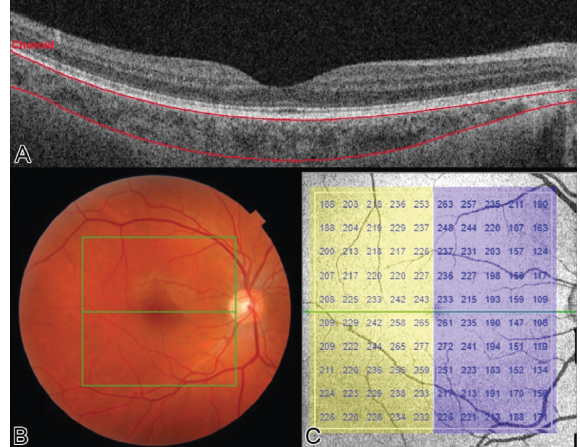
Figure 2: Choroidal evaluation of a right macula. (a) Optical coherence tomography (OCT) of showing a B-scan at the fovea with the choroidal layer outlined in red. (b) Fundus photography of the right eye and the macular area of OCTacquisition delimited in green. (c) Posterior pole map of the right eye divided into nasal (blue) and temporal (yellow) hemiretina and columns from 1 to 10. In the left eye, the columns maintain the sequence from temporal to nasal, inverting the order of the numbers (10 to 1). Table 1: Demographic data of study participants.